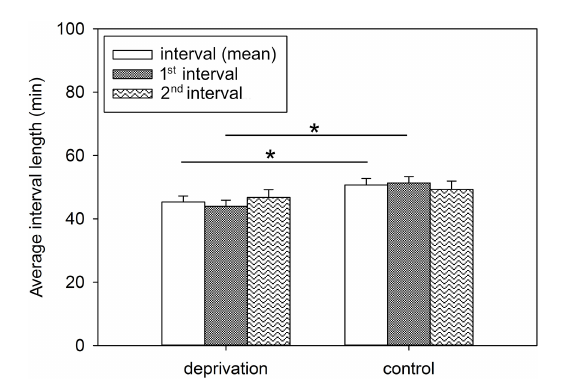
FIGURE1 Average interval lengths between suckling bouts of deprivation and control litters. Results are presented as LSM ± SE. Significant differences are marked with asterisks (* p < 0.05; Tukey-Kramer test; n = 10 litters/treatment group). 1st interval, interval between 1st and 2nd suckling bout; 2nd interval, interval between 2nd and 3rd suckling